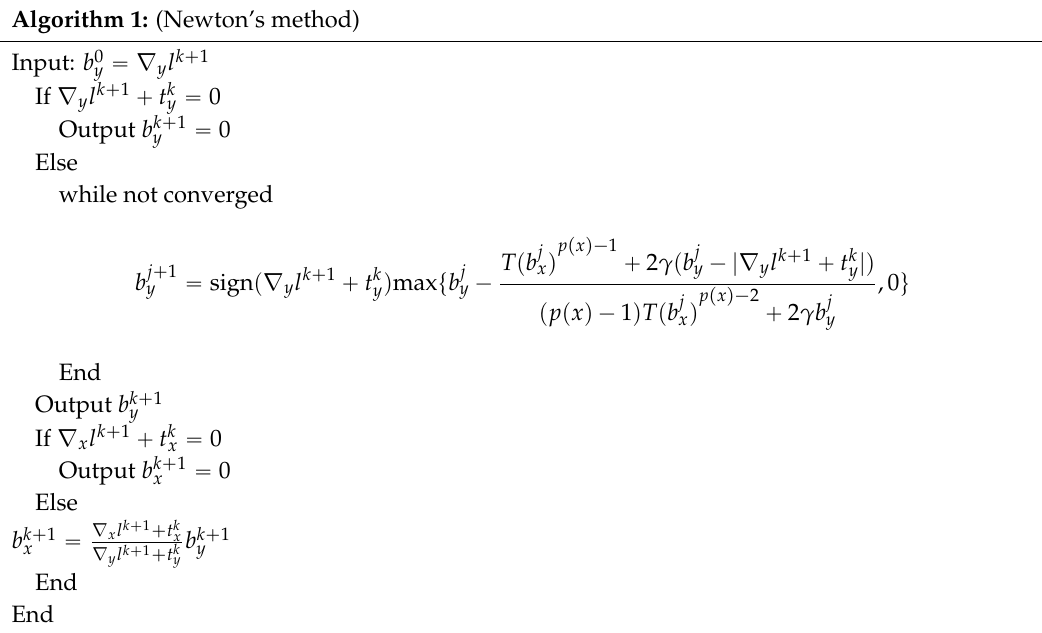
Algorithm 1: (Newton’s